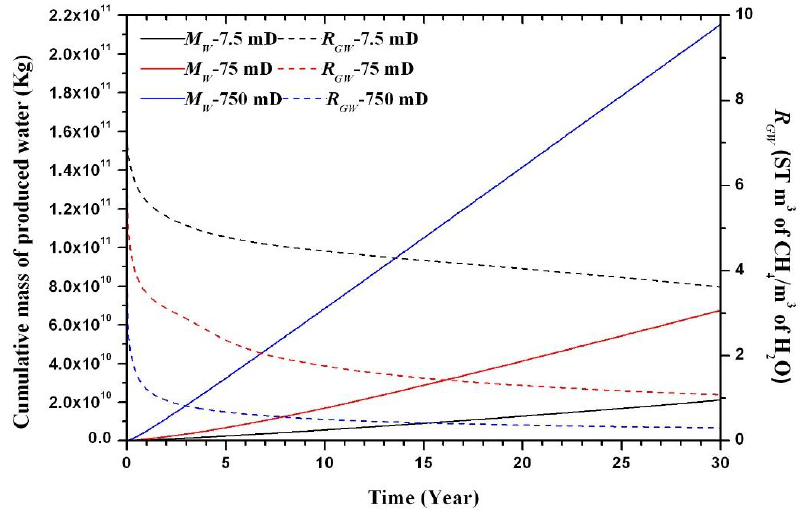
Figure 19. Sensitivity to the intrinsic permeability ( k ): evolution of M W and R GW overtime.